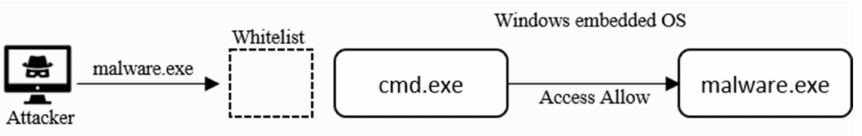
Figure 14. DAC-based whitelist security system.